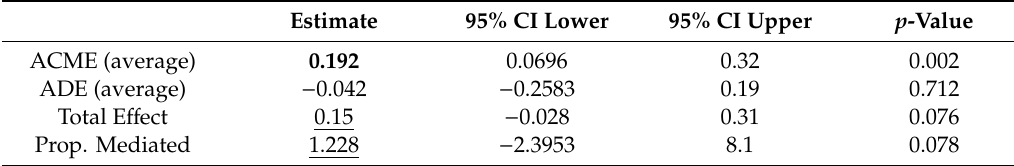
Table 6. Mediation analyses of NCDs and mediator ParkRx on use